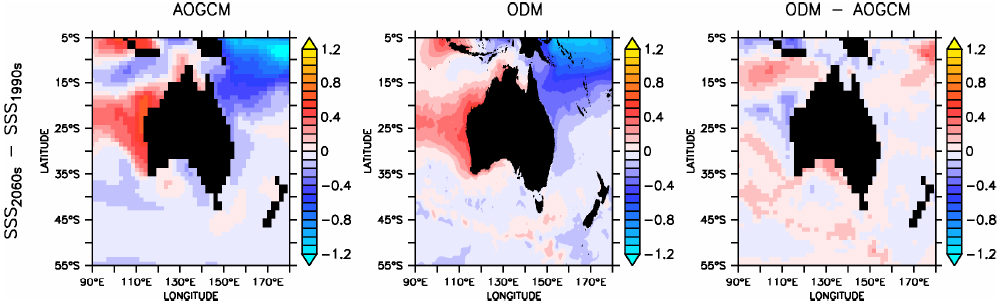
Fig. 10. 10-yr averages of the projected climate change in SSS (psu) for the AOGCM, ODM, and their difference.